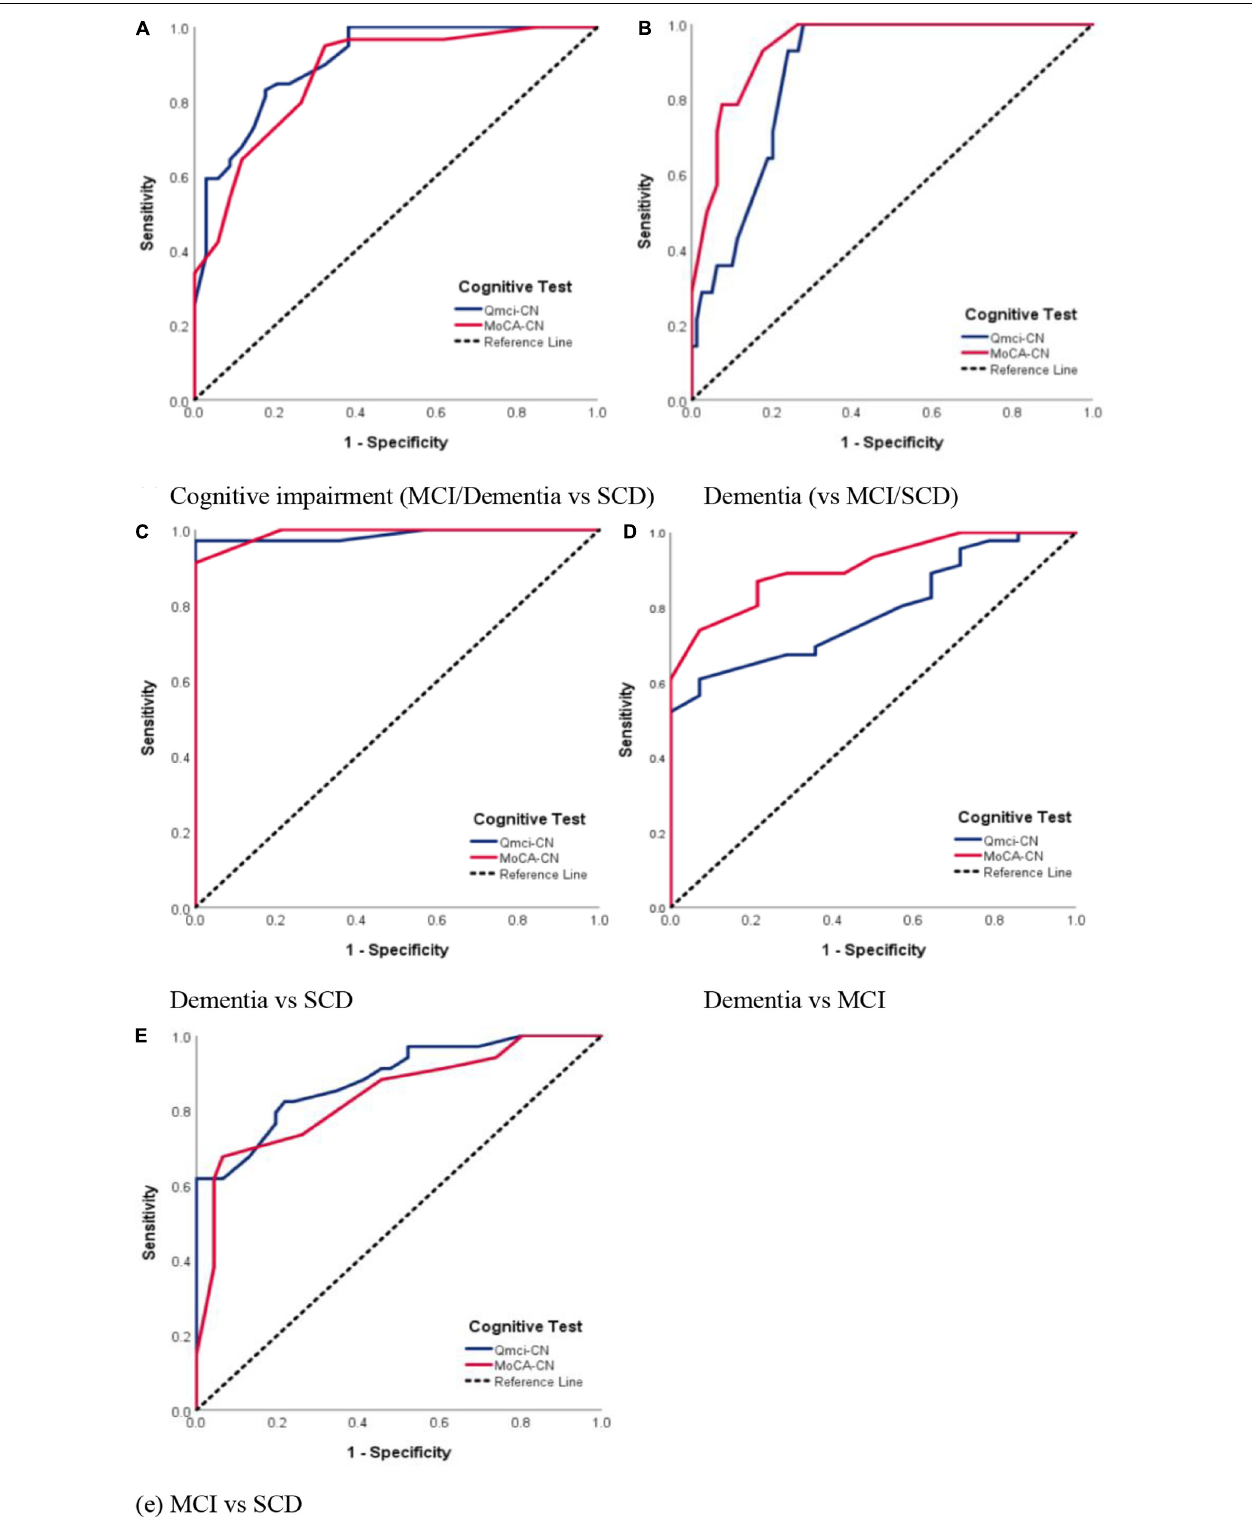
FIGURE 3 | Receiver Operating Characteristic (ROC) curve analysis comparing the Chinese versions of the Quick Mild Cognitive Impairment (Q mci -CN) screen and Montreal Cognitive Assessment (MoCA-CN) in separating subjective cognitive disorder (SCD), mild cognitive impairment (MCI) and dementia. (A) Cognitive impairment (MCI/Dementia vs. SCD). (B) Dementia (vs. MCI/SCD). (C) Dementia vs. SCD. (D) Dementia vs. MCI. (E) MCI vs. SCD.